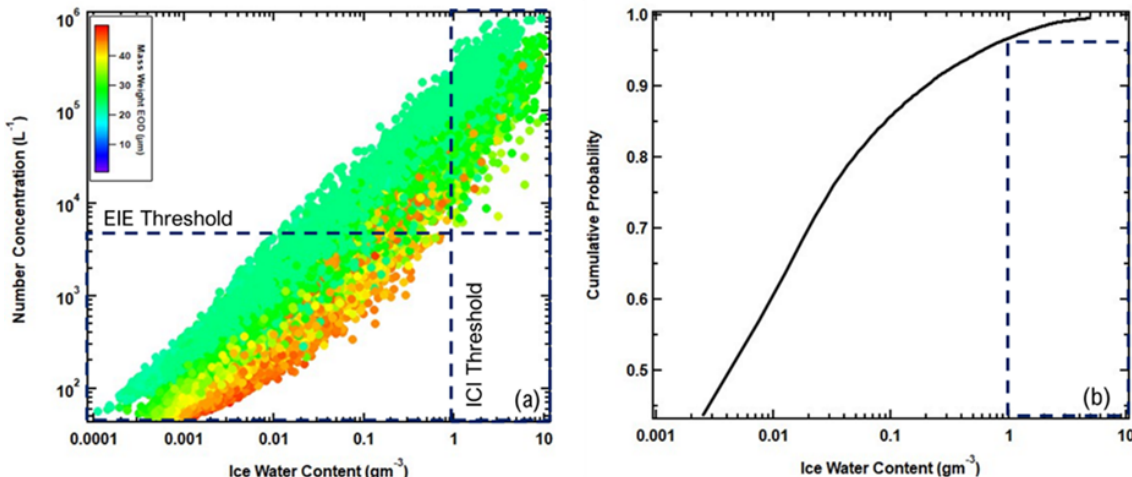
Figure 18. (a) Ice water content (IWC), derived from the BCP size distributions, compared with N ice , color-coded by the mass weighted diameter. The vertical dashed black lines marks the IWC concentration that is considered a threshold for high IWC (HIWC) by the ICI community, which studies the impact of ice crystals on aircraft operations. The horizontal dashed lines demarcate the N ice threshold for EIEs. (b) The cumulative frequency distribution, normalized by total measured clouds, shows that of the 42690 clouds measured, approximately 5% (2135) of them exceeded the HIWC